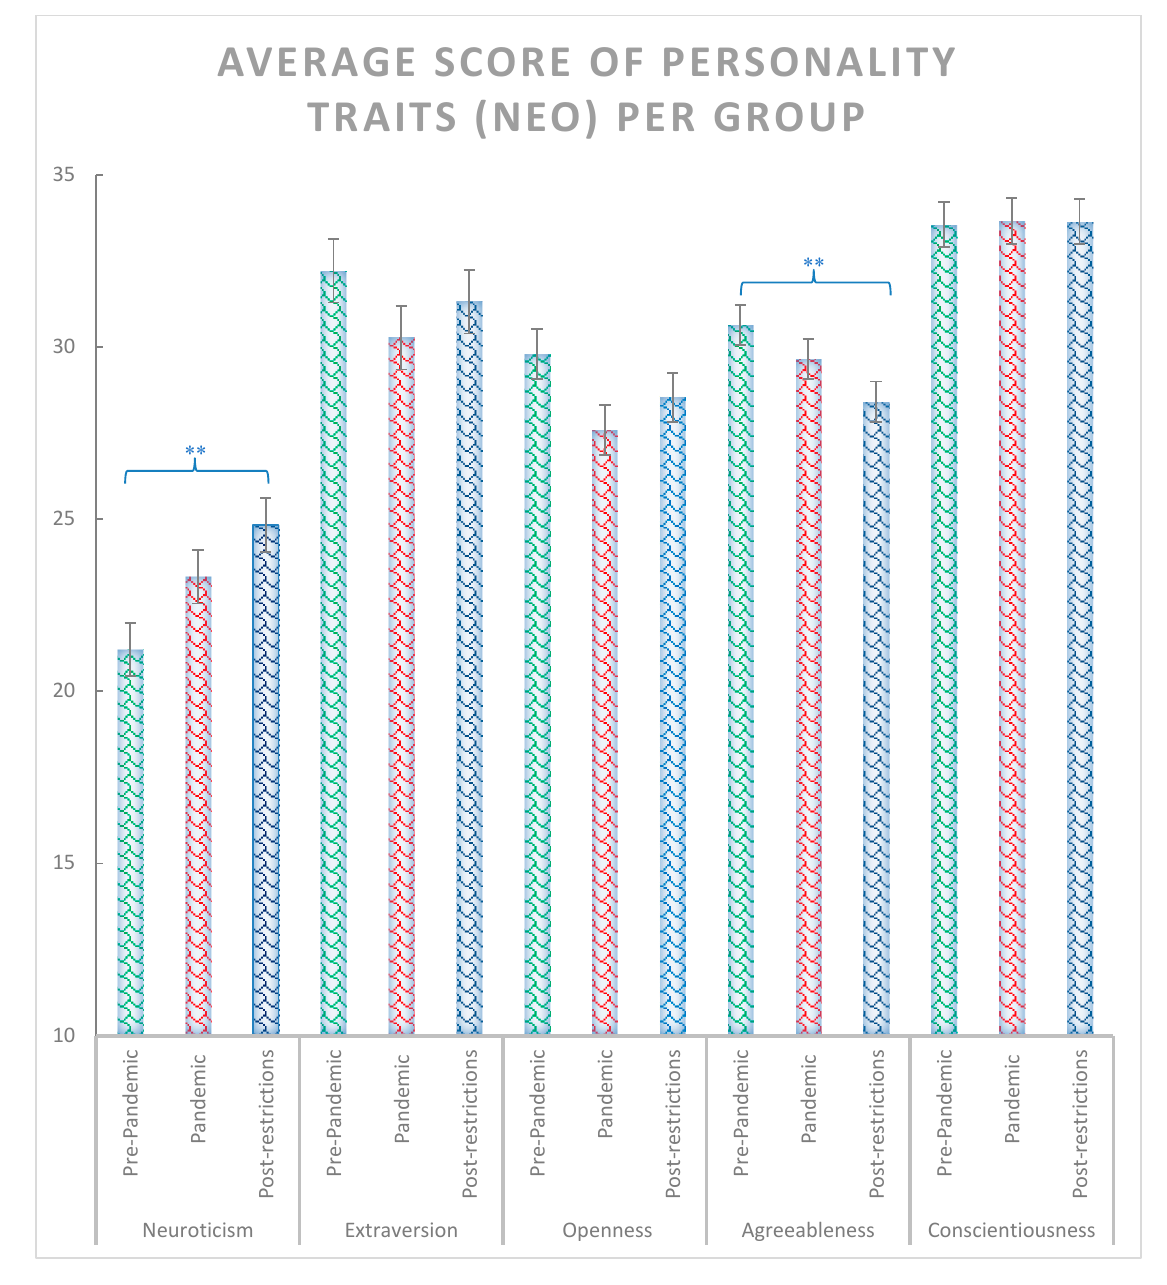
Figure 5. Average scores for neuroticism, extraversion, openness, agreeableness, conscientiousness personality traits assessed with the NEO personality questionnaire for pre-pandemic, pandemic, and post-restrictions group. Where ** = p < 0.01. Bars indicate error rates.